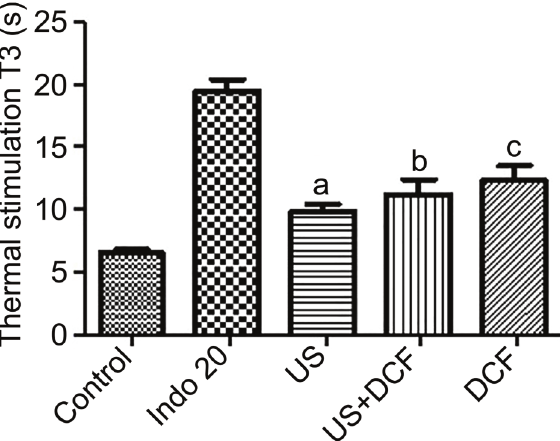
Figure 1. Evaluation of acute treatment on the volume of paw edema 3 h after carrageenan administration in rats treated with ultrasound (US), ultrasound associated with diclofenac diethyl- ammonium (US + DCF), and diclofenac diethylammonium alone (DCF). Data are reported as mean ± SE. Indomethacin 20 mg/kg ( po ) was used as reference drug. a P o 0.001, b P o 0.05, c P o 0.001, e P o 0.01 vs control; d P o 0.05 vs US (ANOVA).